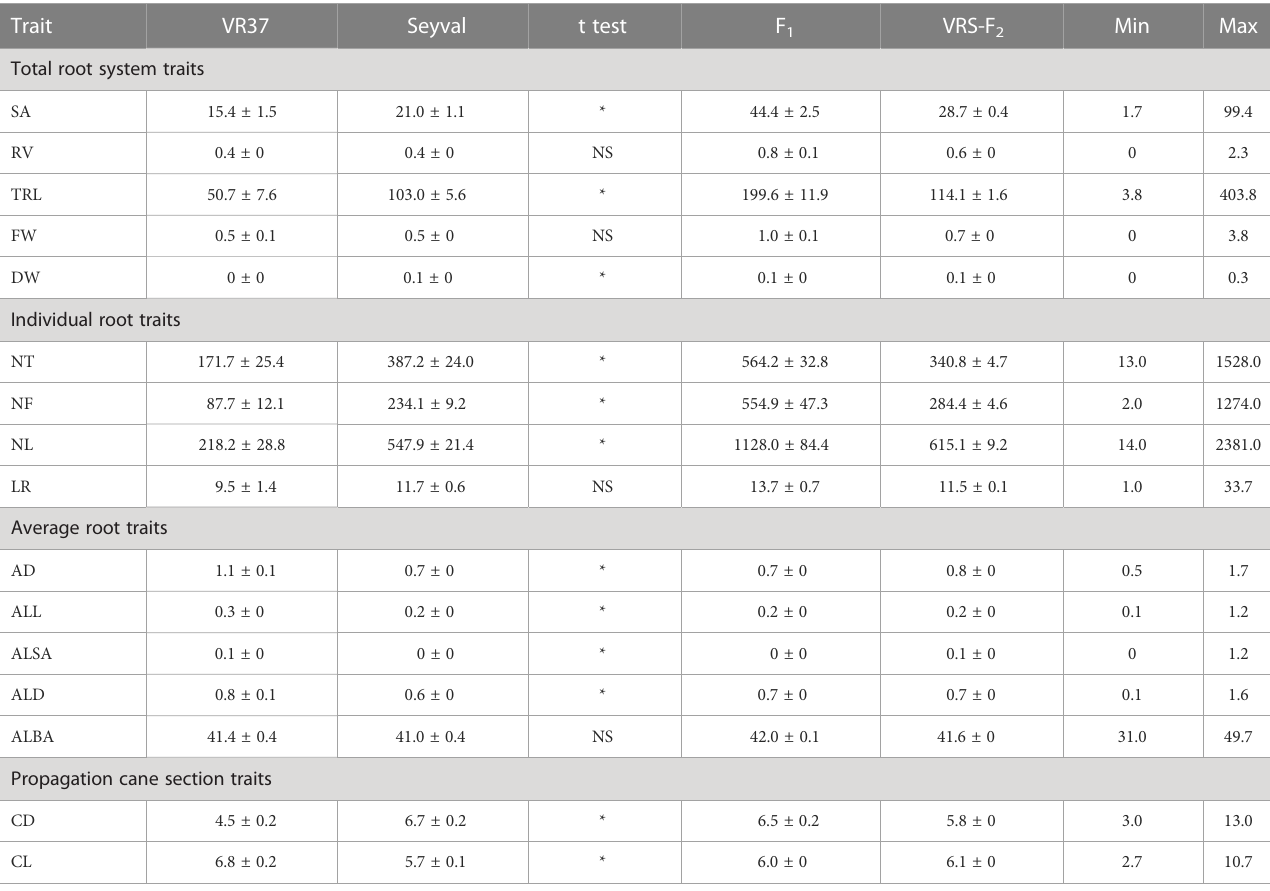
TABLE 2 Descriptive RSA trait statistics for V. riparia ‘ Manitoba 37 ’ and ‘ Seyval blanc ’ (grandparents), F 1 (parent), and the F 2 population. Trait